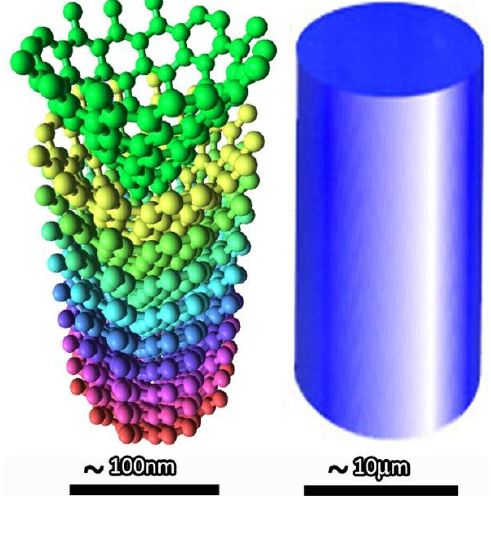
Figure 1. Schematic illustration of the difference between CNF and